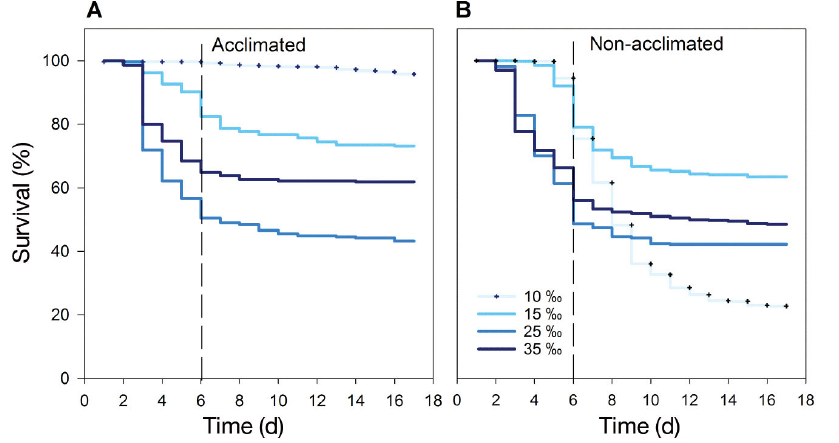
Fig. 4. Survival of Pacific oysters Crassostrea gigas exposed to the source of infection at 4 salinities (A) with or (B) without prior acclimation. Survival time was measured as days from the onset of exposure to the source of